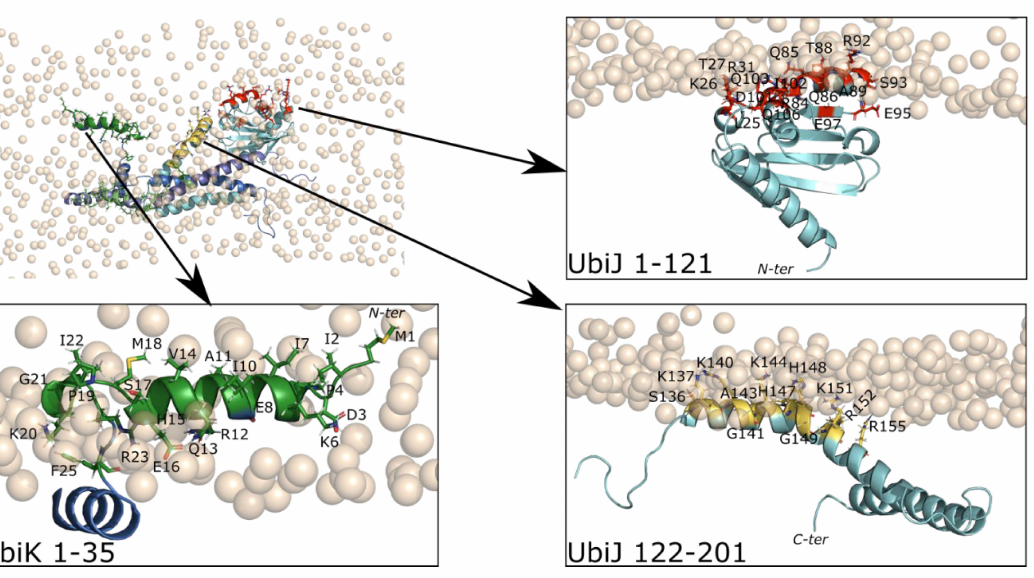
Figure 10. Heterotrimer model in interaction with the membrane. On the top left a top view of the adsorption is illustrated with the heterotrimer in cartoon and the polar head groups of lipid membrane in orange spheres. For clarity, three zoomed views are shown for key interacting regions. The stable residues in contact with the membrane are listed on the bottom. The colour code is the following: red for SCP2 of UbiJ, yellow for the residues 122–201 of UbiJ, green for residues of UbiK. Bold red labels correspond to common residues between single SCP2 and heterotrimer. Italic red labels correspond to specific residues from single SCP2 MD